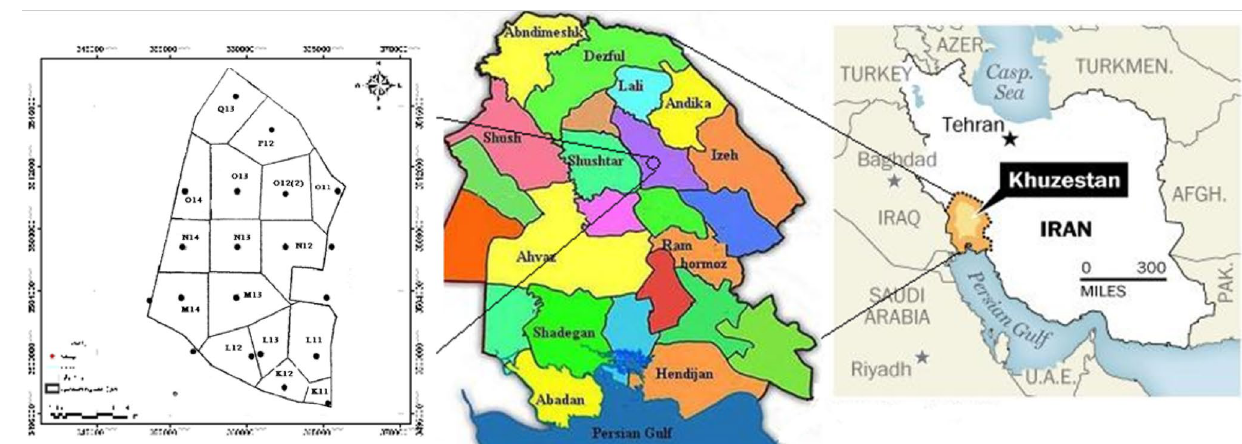
Fig. 1 Spots of hydraulic conductivity measuring